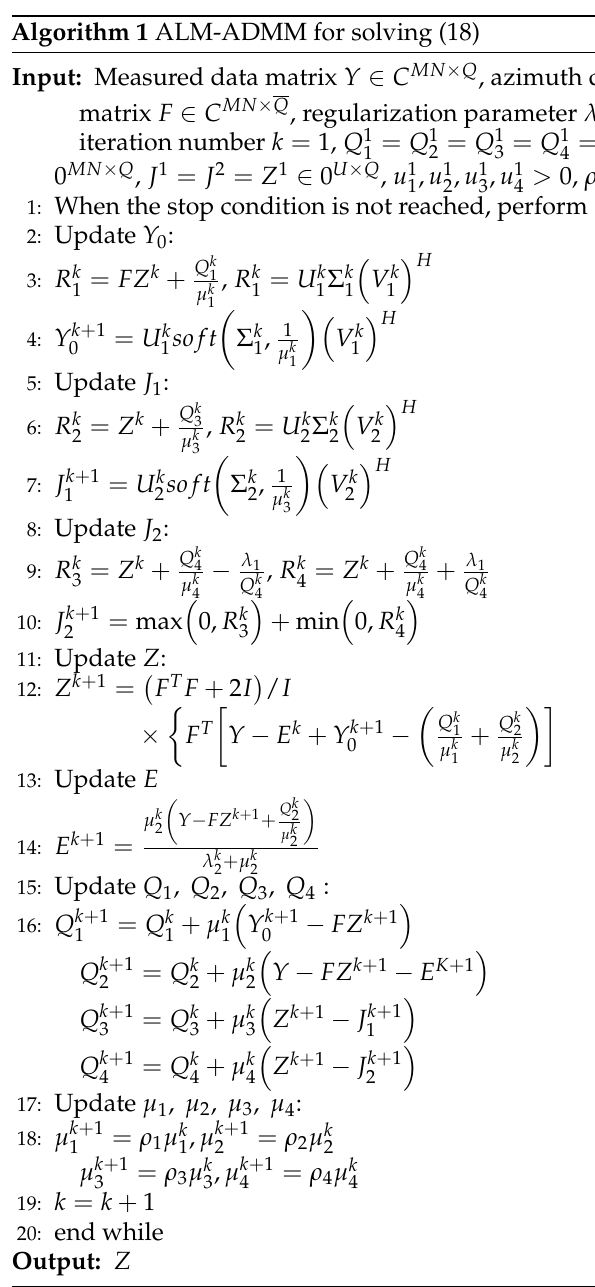
Algorithm 1 ALM-ADMM for solving